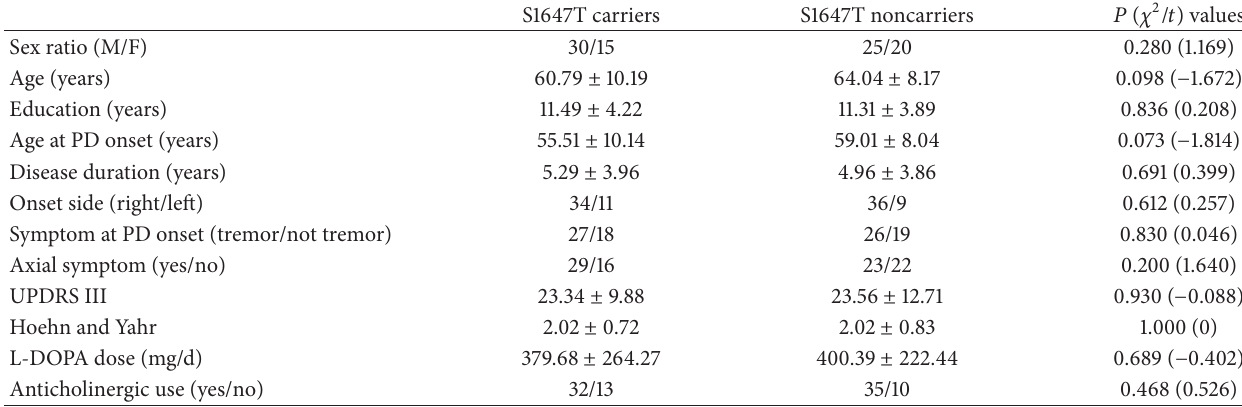
Table 1: General demographic and clinical characteristics of patients with